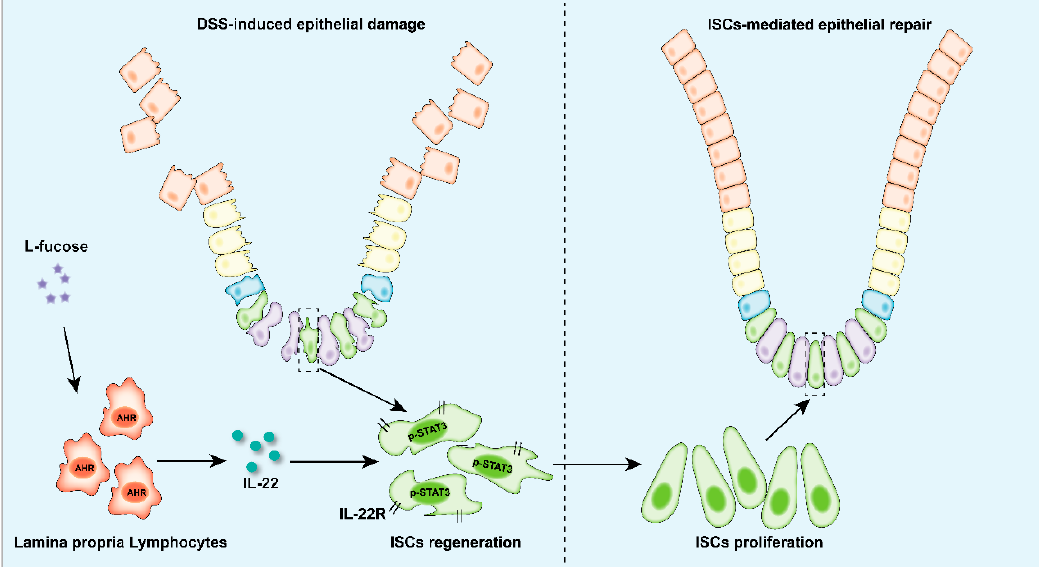
Figure 9. Schematic depiction of the stimulatory effects of L-fucose on LPMCs and ISCs in the colitis colon.